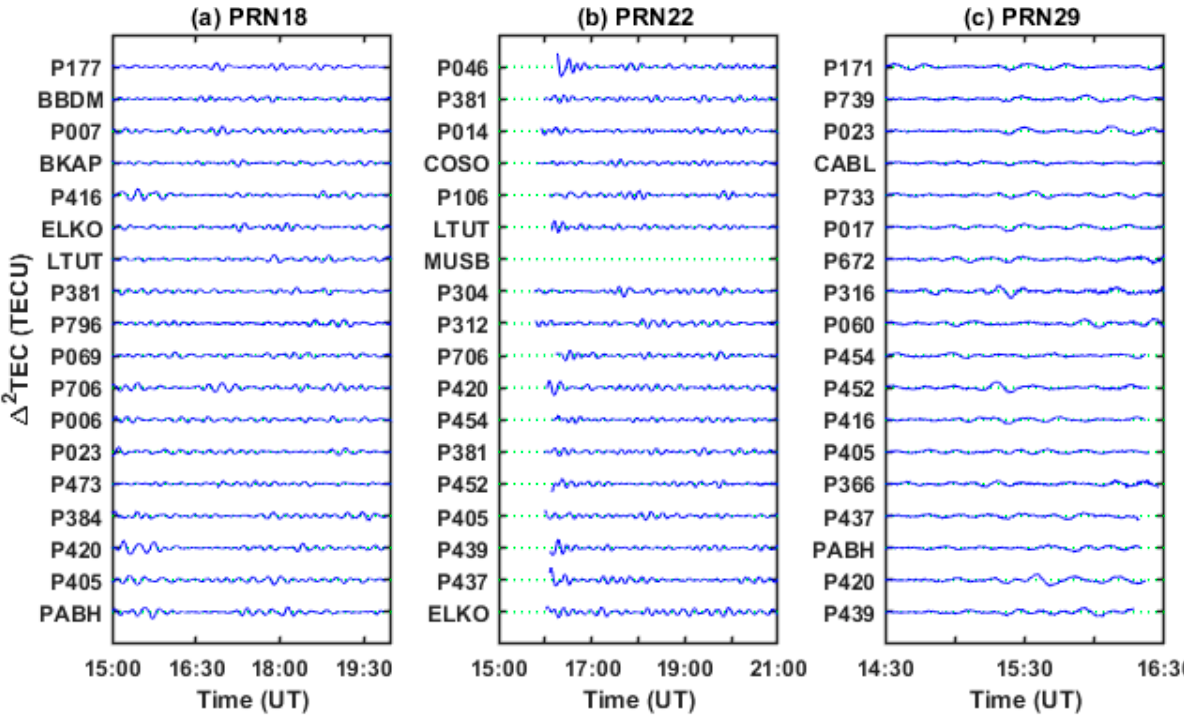
Figure 10. ∆ 2 TEC time series of PRN 18, PRN22, and PRN29 observed from different GPS stations between 14:30 UT and 21:00 UT on 12 March (a day after the tsunami). Results from each station are vertically shifted from the previous station by two TECU in ( a ) and ( b ), and results from each station are vertically shifted from the previous station by one TECU in ( c ).